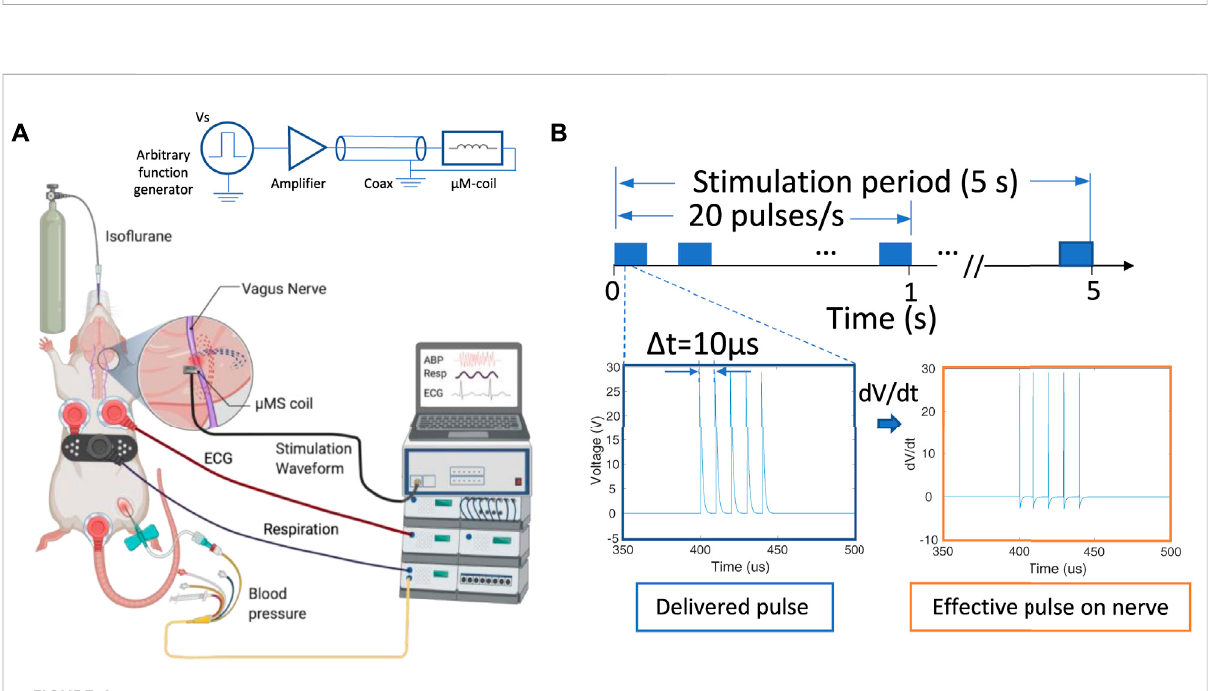
FIGURE 4 Overview of the µM-VNS experiment; (A) Overview and schematic of the experimental set-up; (B) stimulation pulses used for µM-NS that was composed of fi ve exponential decaying pulse trains with a pulse width of 10 µs each at 20 Hz with Vp-p = 29.2 ± 3.1 V with the stimulation time for 5 s (left), and the effective pulse delivered to the nerve (right) (Figure created with